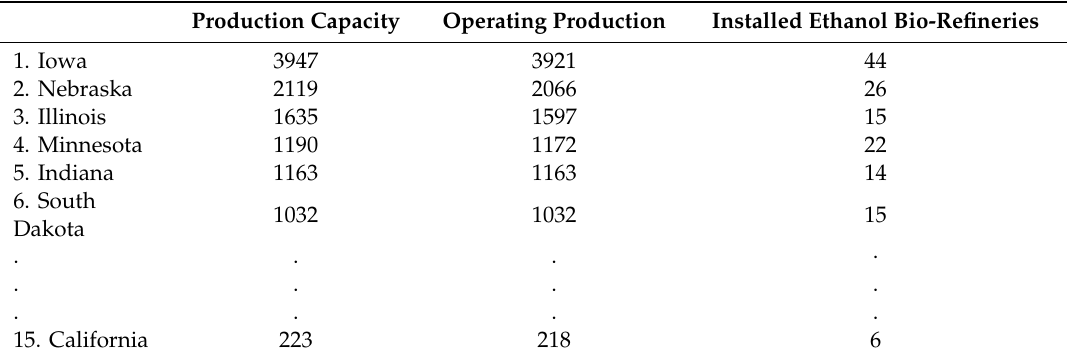
Table 1. Ethanol production capacity (million gallons / year) and production facilities by state. (Source: 2016 Ethanol Industry Outlook by Renewable Fuels Association)